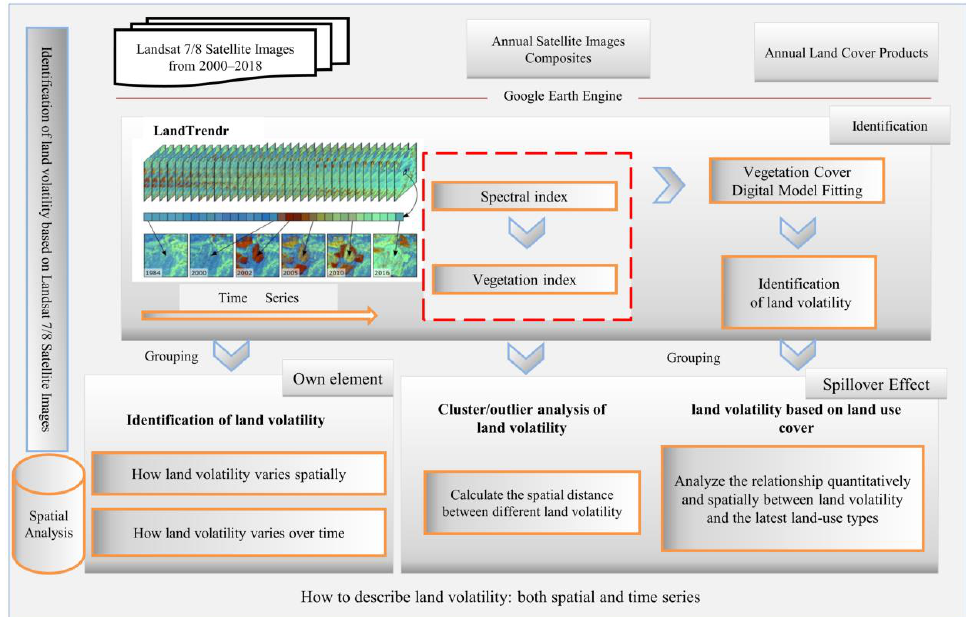
Figure 4. Research framework.